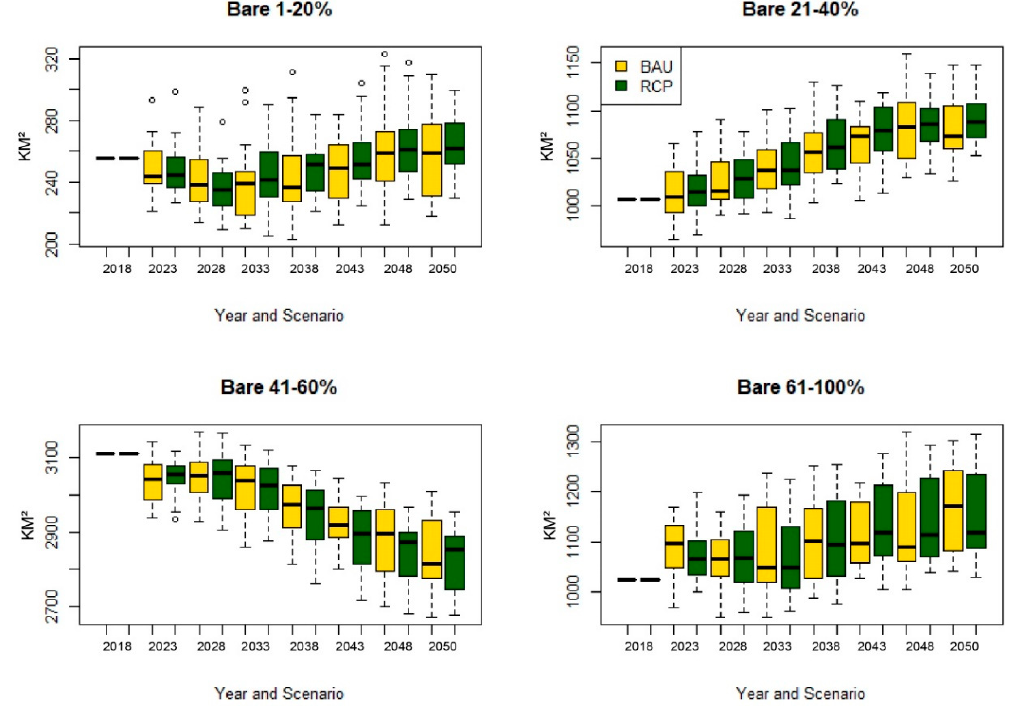
Figure 5. BAU and RCP 8.5 scenario results for bare ground (km 2 ), summarized across the entire study area. Variance and means were calculated from across the 30 model runs. Data from 2018 have no error bars as they were observed directly using BIT data. The y -axis varies between plots.